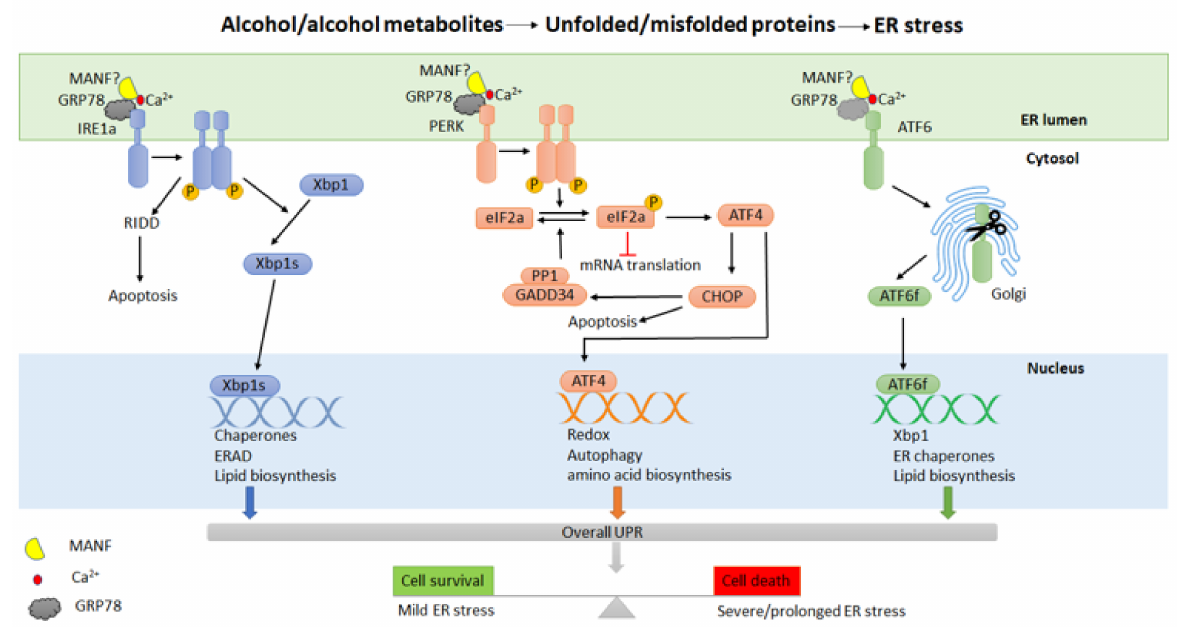
Figure 1. Alcohol exposure and ER stress. Alcohol and its metabolites may cause ER stress and induce a cellular adaptive response known as the unfolded protein response (UPR) in the pancreas. UPR is controlled by three transmembrane sensor proteins: inositol-requiring enzyme 1 α (IRE1 α ), protein kinase RNA-like ER kinase (PERK) and activating transcription factor 6 (ATF6). Under non-stressed conditions, these sensor proteins bind to GPR78 and possibly MANF in a calcium-dependent manner. Alcohol exposure results in the accumulation of unfolded or misfolded proteins in the ER, in turn causing the release of GRP78/MANF to activate UPR. The activation of UPR regulates transcriptional and translational programs by restoring protein folding, promoting protein degradation, or inducing cell